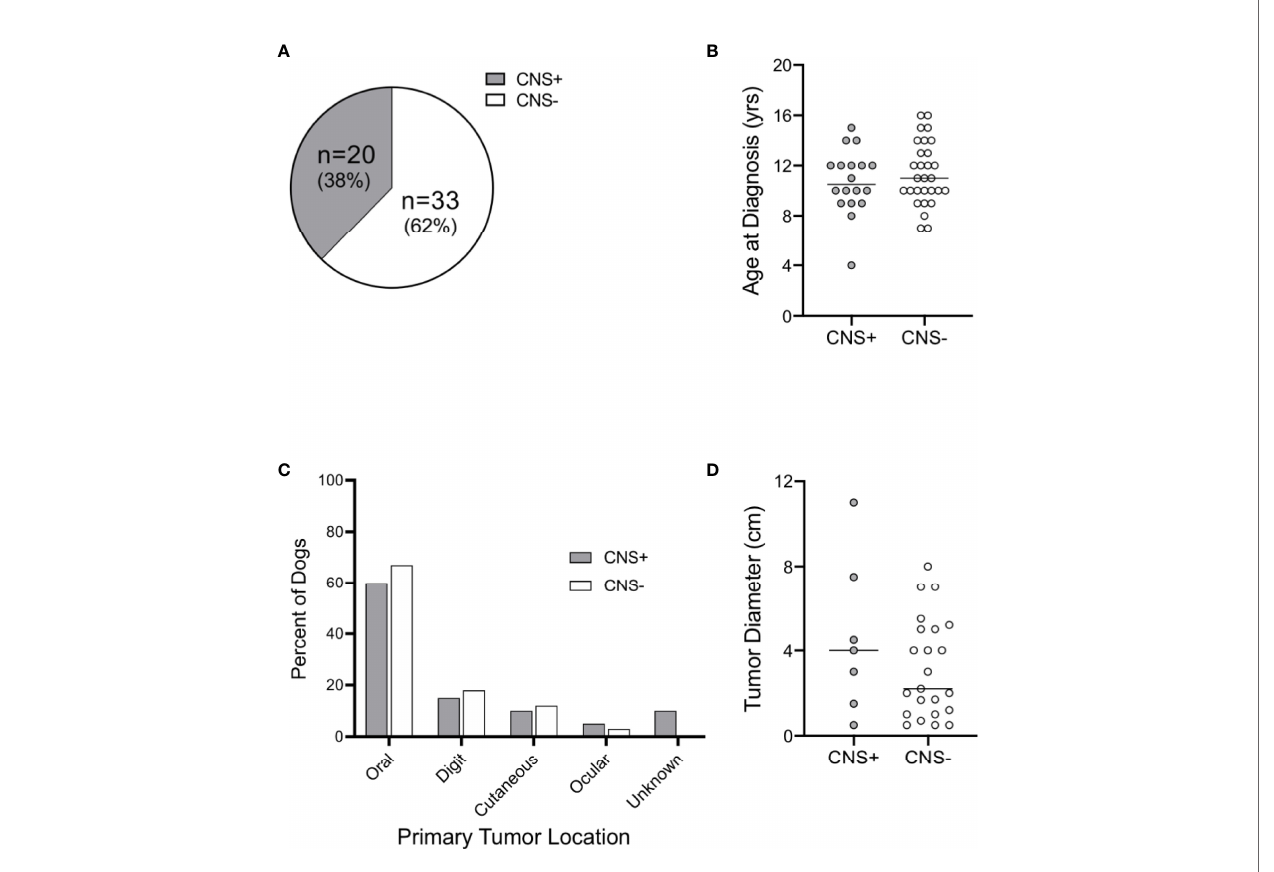
FIGURE 1 | Distribution, age, and primary tumor characteristics of dogs with malignant melanoma. (A) Distribution of dogs with central nervous system (CNS) metastasis of malignant melanoma at the time of necropsy. (B) Median age at diagnosis was similar between groups. Primary tumor (C) distribution and (D) diameter were similar between CNS+ andCNS- dogs (primarytumor site was not determined for 2 CNS+ dogs). Comparisonsbased on Wilcoxon-Mann-Whitney rank